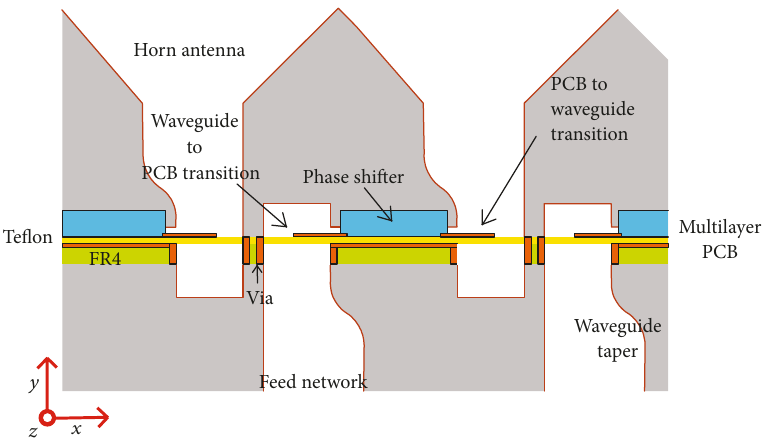
Figure 1: Cutaway picture of a small section of the proposed phased horn antenna array from the side. The feed network is realized with waveguides and only the output waveguides of the feed network are shown. Phase shifters are realized on a multilayer